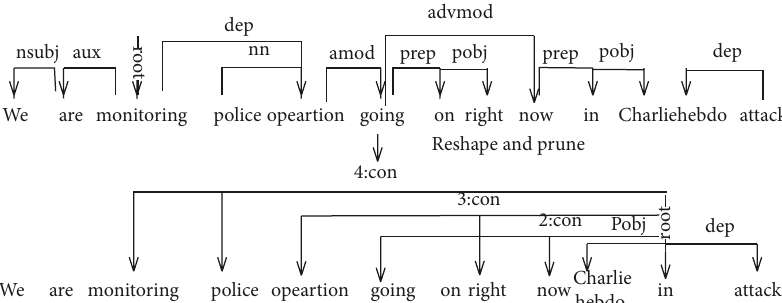
Figure 2: Schematic diagram of common dependency tree and modified and deleted topic dependency tree.